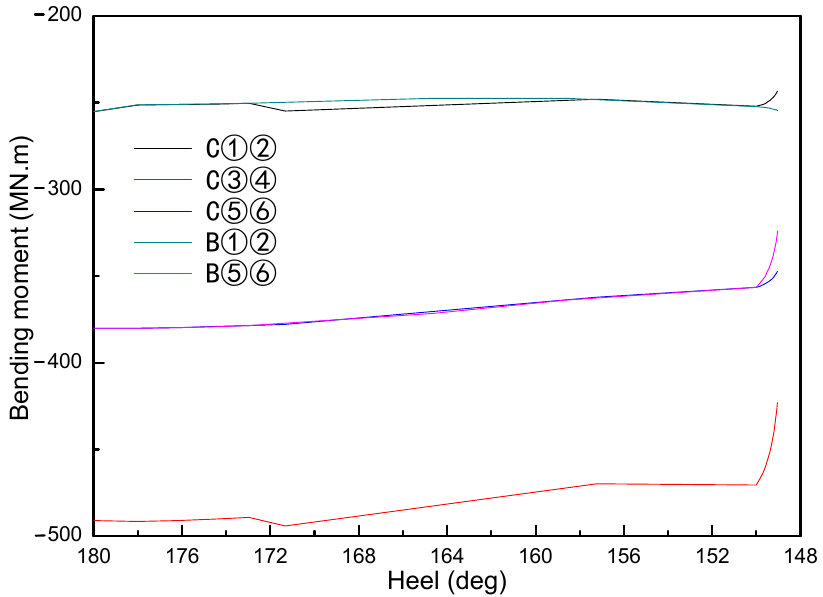
Figure 9. Variation of bending moment under case Ⅲ .